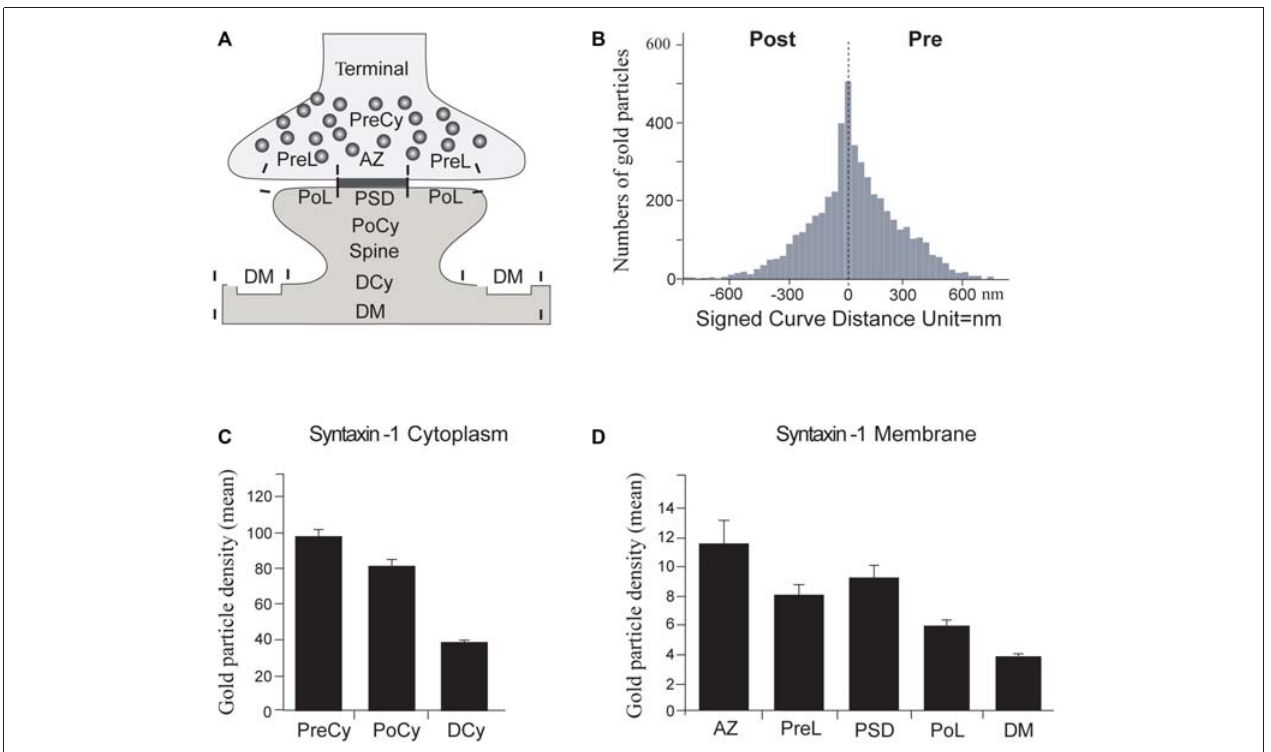
FIGURE 5 | Quantitation of synaptic syntaxin-1 immunogold labeling. (A) Schematic drawing showing regions of interest in electron micrographs. PreCy, Presynaptic Cytoplasm; PreL, Presynaptic Lateral plasma membrane. AZ, Active Zone; PoCy, Postsynaptic Cytoplasm; PoL, Postsynaptic Lateral plasma membrane; PSD, PostSynaptic Density; DCy, Dendrite Cytoplasm; DM, Dendritic plasma Membrane. (B) Transverse histogram depicting the mean number of gold particles at every 30 nm distance from the center of the synaptic cleft, negative values are postsynaptic, positive values are presynaptic. The peak is over the synaptic plasma membranes. (C) Mean immunogold labeling over cytoplasmic regions of interest. (D) Mean immunogold labeling over plasma membrane regions of interest. Error bars show SEM, based on 180 micrographs of